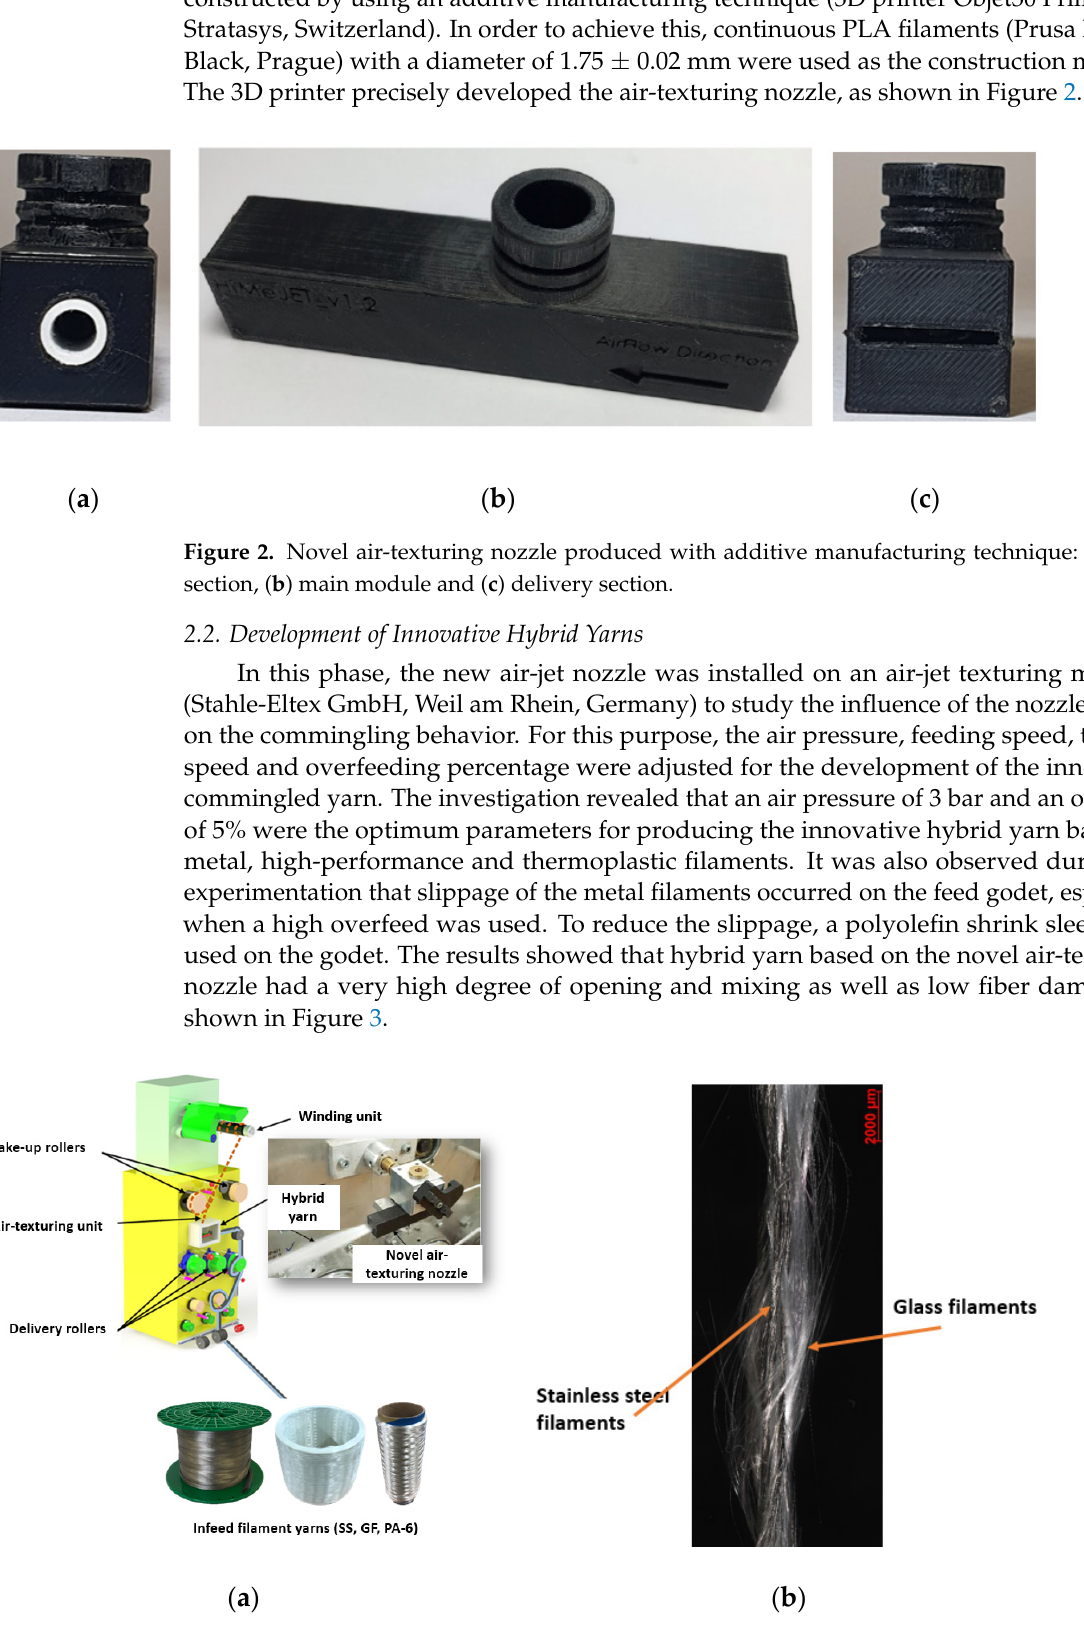
Figure 3. Novel air-texturing nozzle: ( a ) implementation and ( b ) commingling yarn.